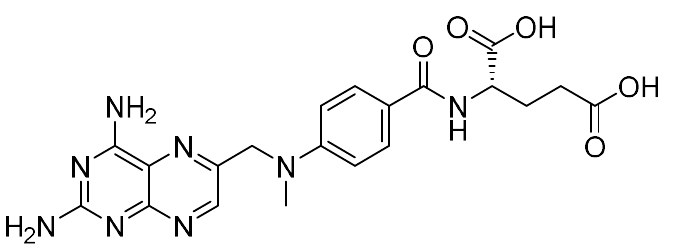
Figure 1. Chemical structure of